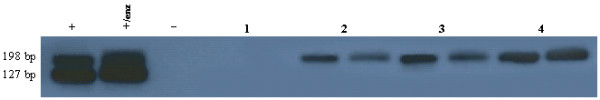
Result of southern blot hybridization for BamHI-F region. Four specimens are seen in this figure, each sample was loaded in 2 lanes with and without enzyme, respectively from left. The first specimen was not amplified in this experiment. The other three specimens were not cleaved by Bam-HI enzyme which means they are wild-type F. (+: positive control; +/enz: positive control with enzyme; -: negative control).